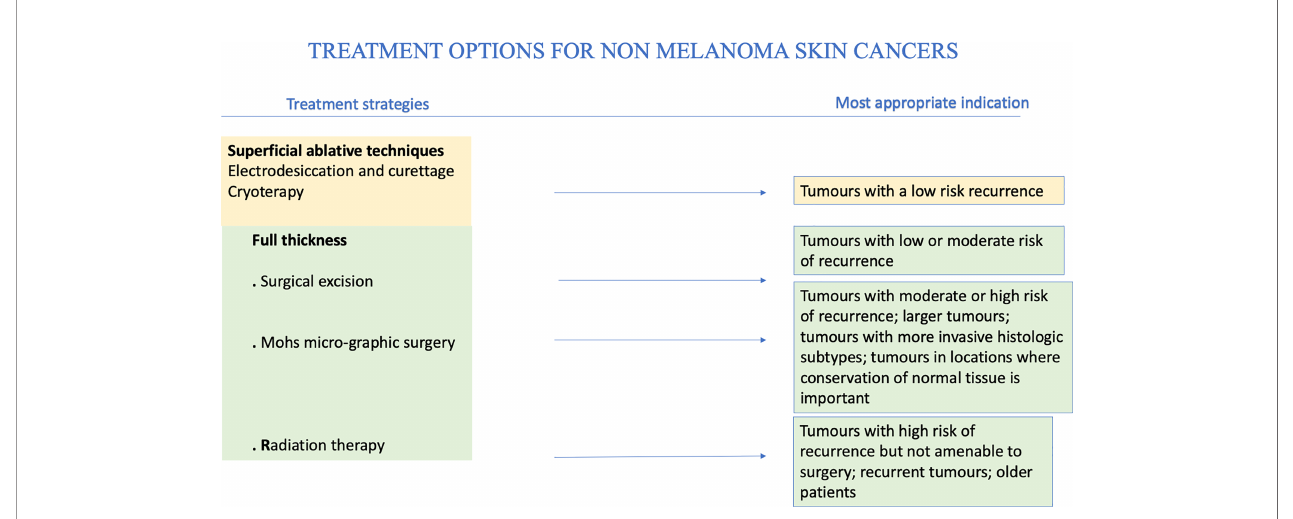
FIGURE 5 | Treatment options for